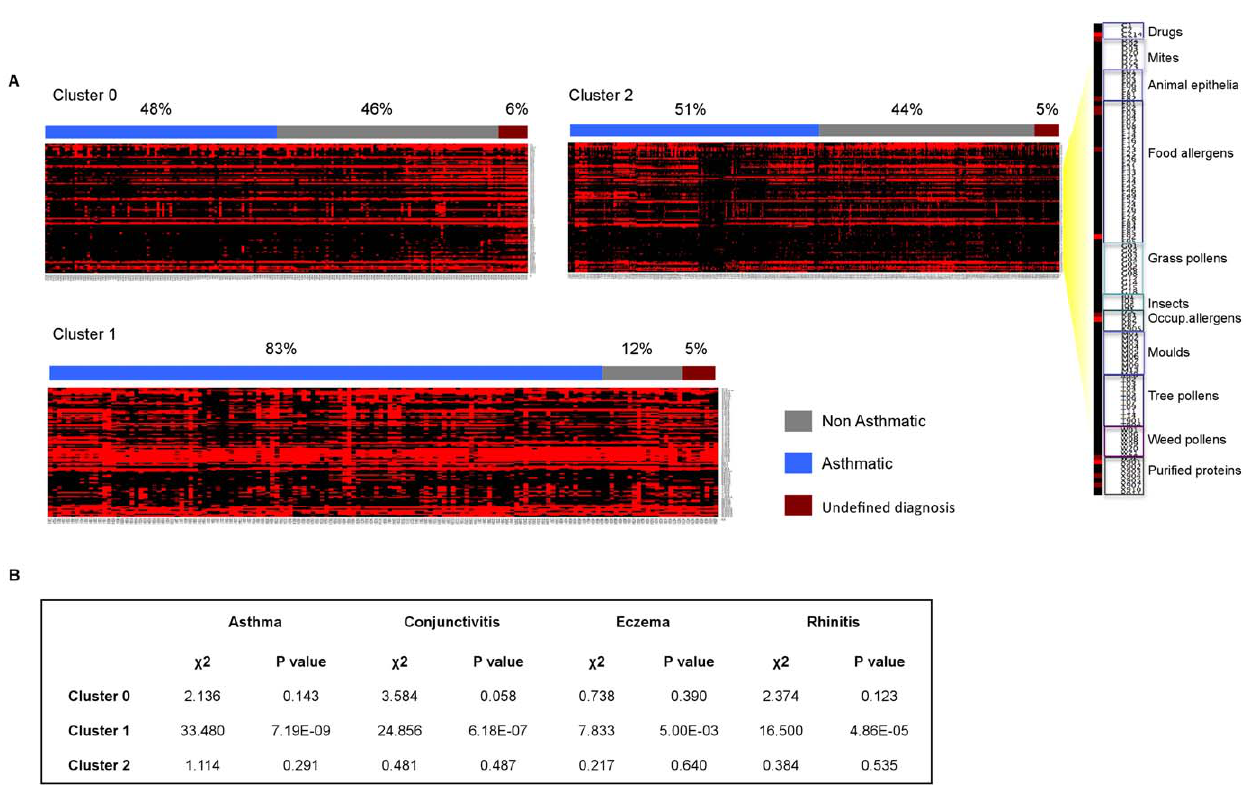
(blue), non-asthmatic (gray) and undefined diagnosis (dark red). Reactivity values to individual allergens are classified as either positive (scale of red - class score 1–5) and negative (black - class score 0). (B) The distribution of atopic conditions in each cluster was assessed using the Pearson’s X 2 test.